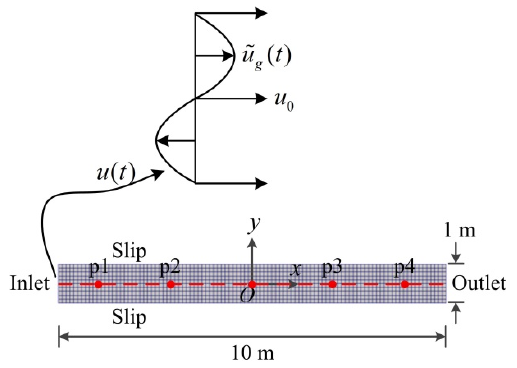
Figure 14. Illustration of the gust model and the probed positions for characterization of the horizontal sinusoidal gusty inflow condition implemented by this study.